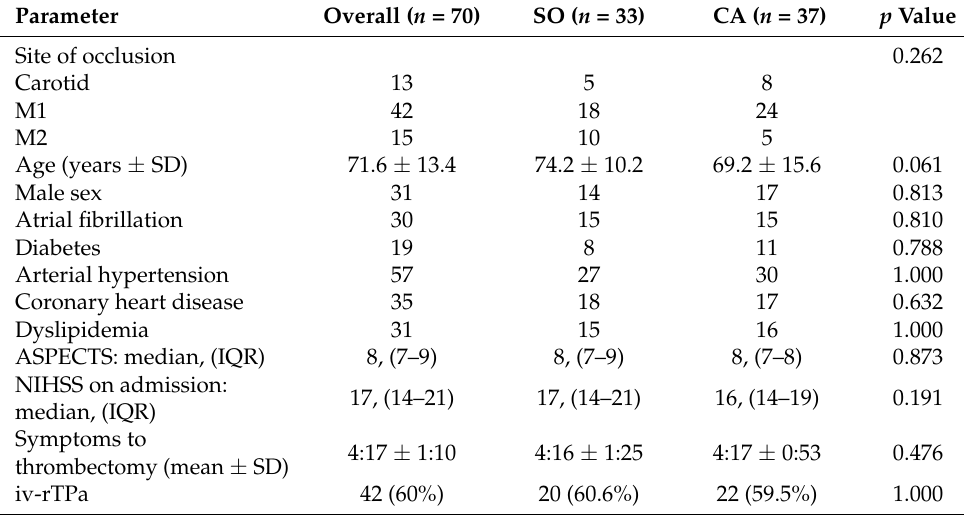
Table 1. Baseline characteristics of the study